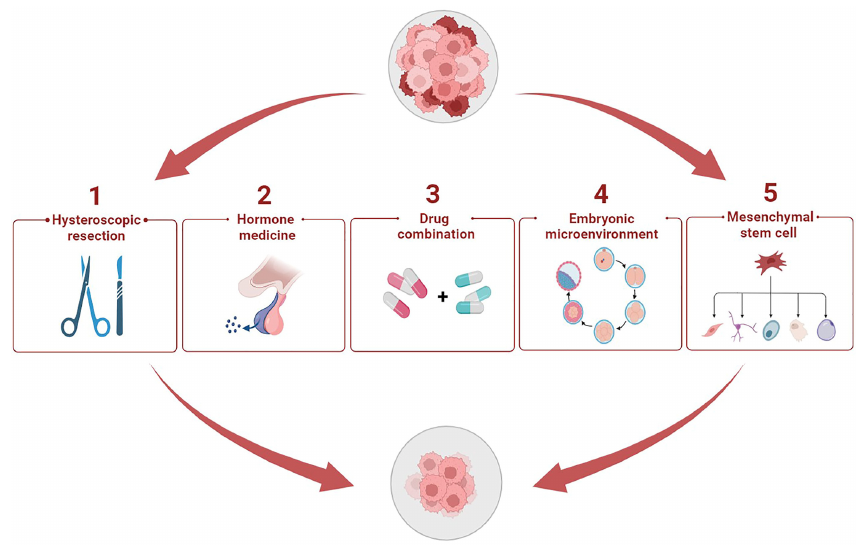
Figure 5. Potential therapeutic methods to reverse progestin resistance. Progestin resistance can be improved in a number of ways. There are five main types of treatment, namely hysteroscopic resection, hormone medicine, drug combinations, cytokines in the embryonic microenvironment, and mesenchymal stem cells.